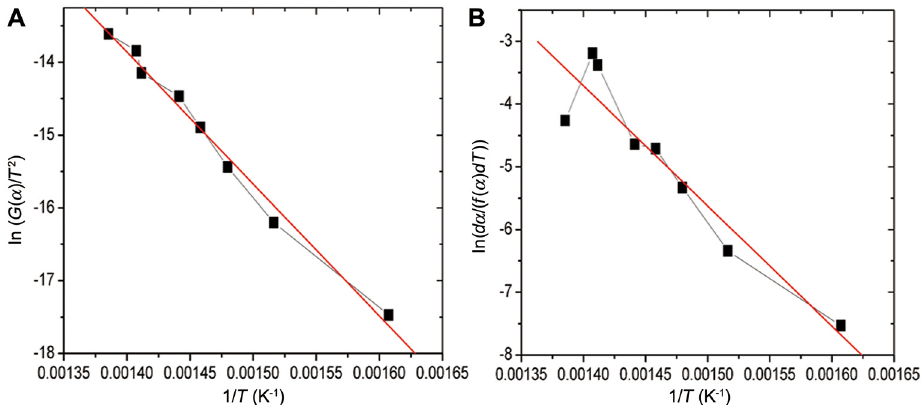
Figure 5 Fitting plots based on No. 5 model at 20 K min -1 : (A) integral method, (B) differential